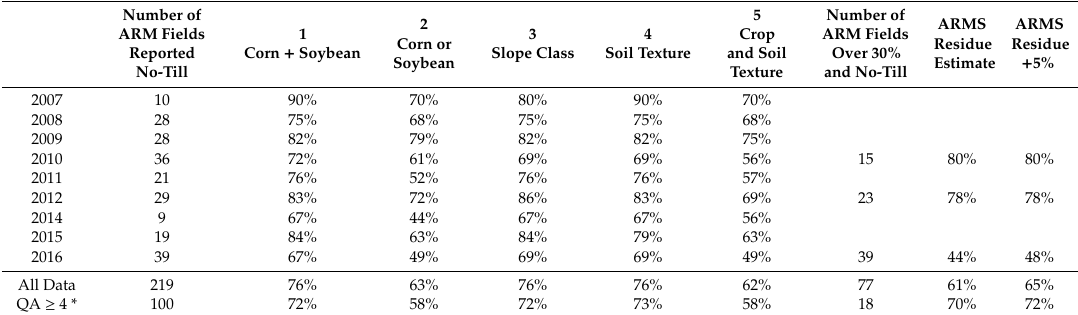
Table 4. Summary statistics of accuracy for the five remote sensing methods and ARMS estimated residue cover compared to ARMS data reporting no-till operations (testing if greater than 30%